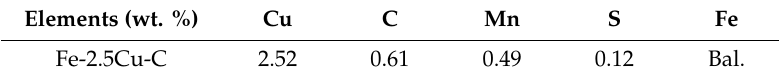
Table 1. Chemical composition of as-received powder-forged Fe-2.5Cu-C alloy. Elements (wt.